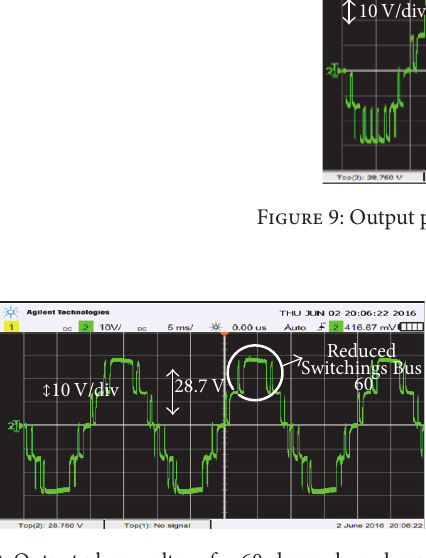
Figure 10: Output phase voltage for 60-degree bus-clamping mod- ulation.